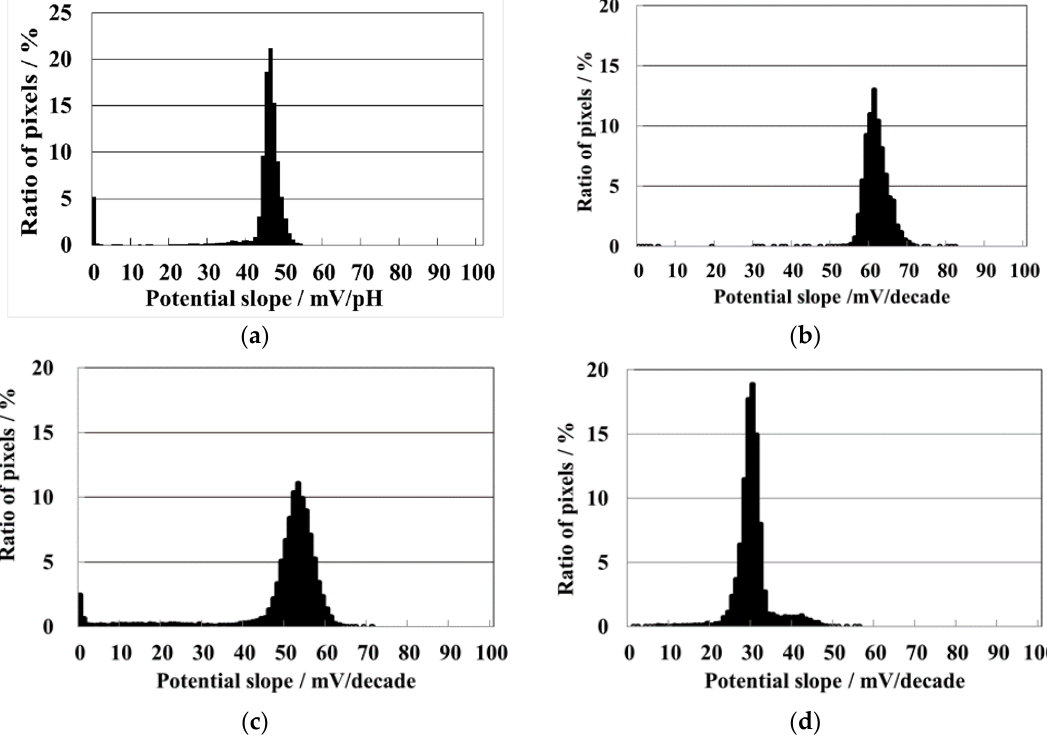
Figure 5. Histograms of potential slopes to ( a ) pH for the rigth upper block; ( b ) sodium ion for the left upper block; ( c ) potassium ion for the right under block; ( d ) calcium ion for the left under block.